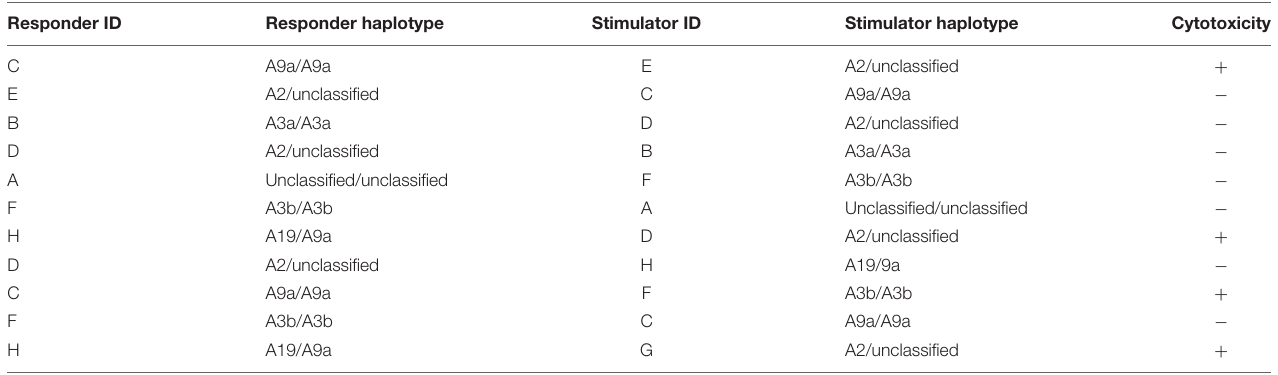
TABLE 2 | MHC haplotypes of responder and stimulator horses for cytotoxicity assays. Responder